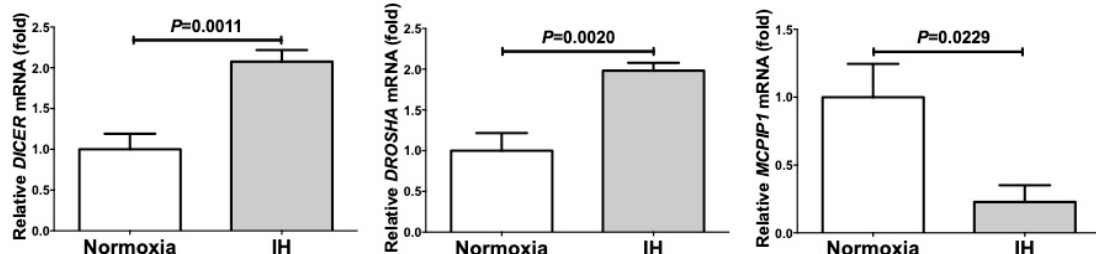
Figure 7. The mRNA levels of ribonuclease type III ( DROSHA ), endoribonuclease Dicer ( DICER ), and monocyte chemotactic protein-induced protein 1 ( MCPIP1 ) of IH-treated Caco-2 cells by real-time RT-PCR. IH significantly increased the mRNA levels of DROSHA and DICER , which are involved in the biosynthesis of miRNAs, and significantly decreased the mRNA level of MCPIP1 , which is involved in the degradation of miRNAs, in Caco-2 cells. All data are expressed as the mean ± SE for each group ( n = 5–6). The statistical analyses were performed using Student’s t